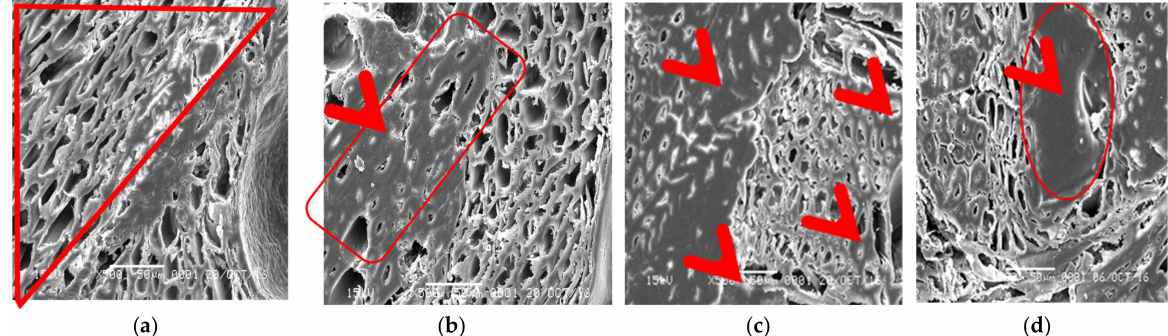
Figure 9. SEM analysis of the particleboards: ( a ) densification on the cell wall of wood particles and ( b ) UF/MDI adhesive combination ratios 100/0, ( c ) 85/15, and ( d ) 70/30 in 500 ×